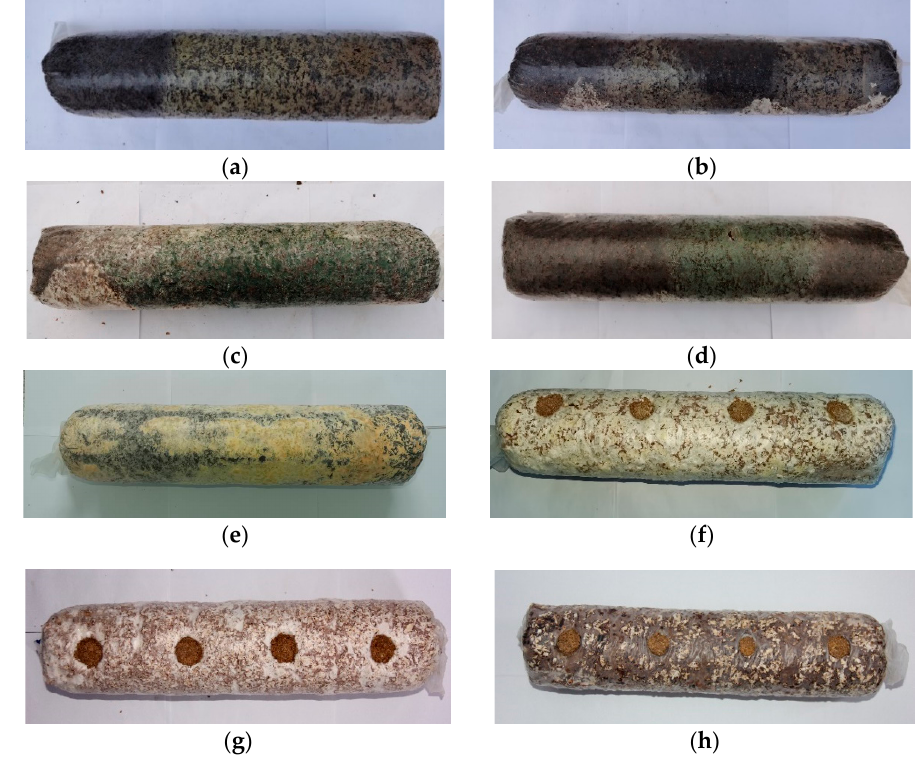
Figure 1. Example of Lentinula edodes log sundry bacteria contamination sample. ( a , b ) are Aspergillus flavus-contaminated Lentinula edodes logs; ( c , d ) are Trichoderma viride-contaminated Lentinula edodes logs; ( e , f ) are Neurospora-contaminated Lentinula edodes logs; ( g , h ) are normal Lentinula edodes logs;